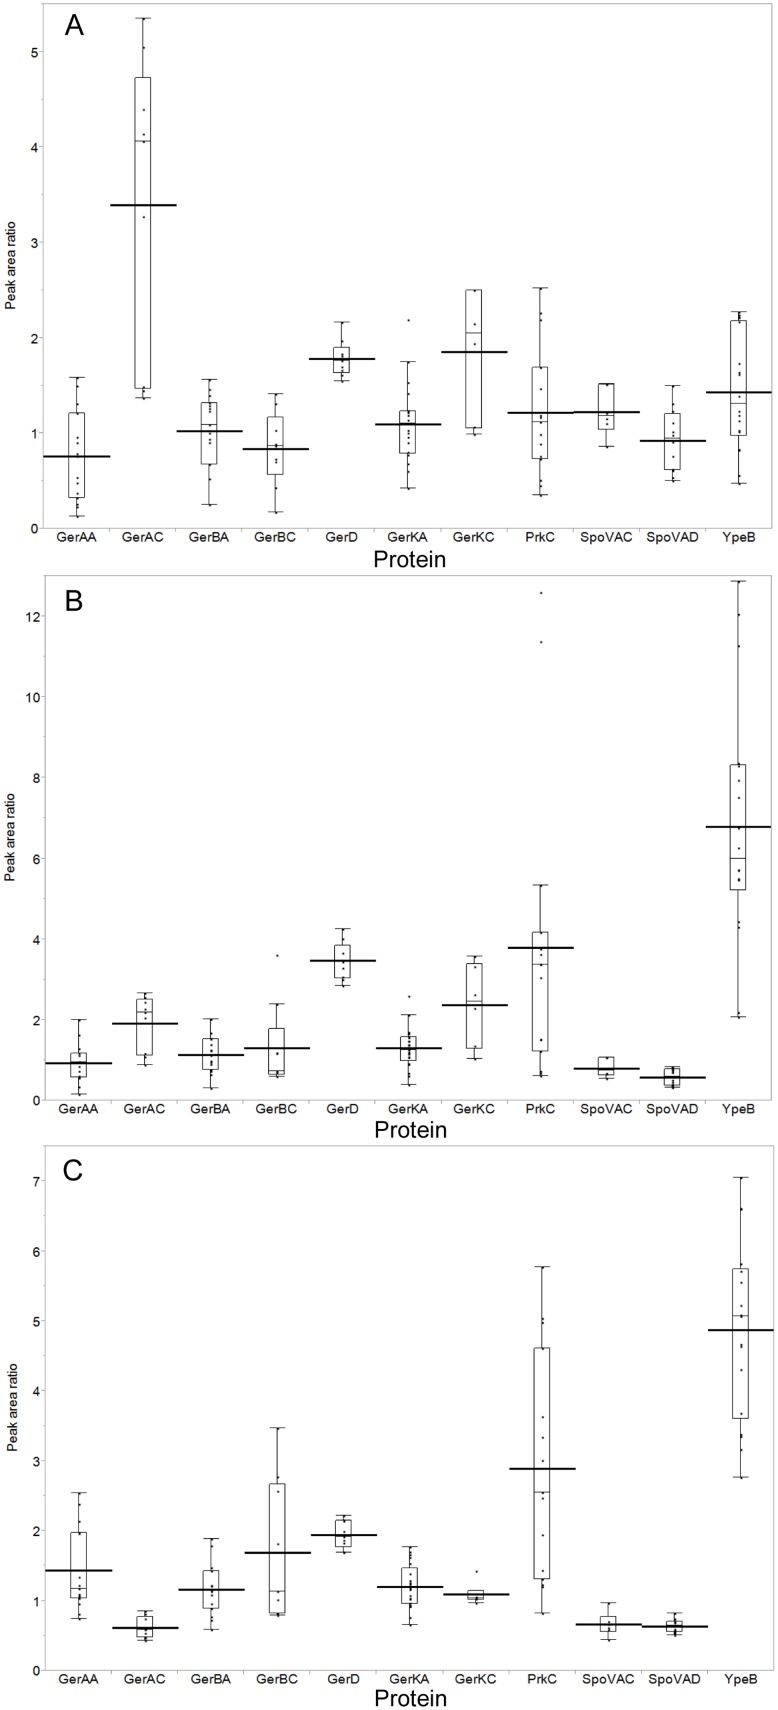
Relative quantities of germination proteins in dormant, superdormant, and germinated spores.Proteins were quantified in membrane samples by MRM analyses. The relative abundance of each protein is expressed as the ratio of each particular product ion peak area detected in dormant versus superdormant (A), dormant versus germinated (B), or superdormant versus germinated (C) spore samples derived from the same spore preparation. Ratios determined for samples from three independent spore preparations were then pooled. Each box and whisker plot indicates individual product ion ratio values (dots), 25–75 percentiles (boxes) and full ranges (whiskers), excluding statistically determined outliers. Means are indicated by the short lines traversing the boxes and medians are shown by the lines traversing the boxes.